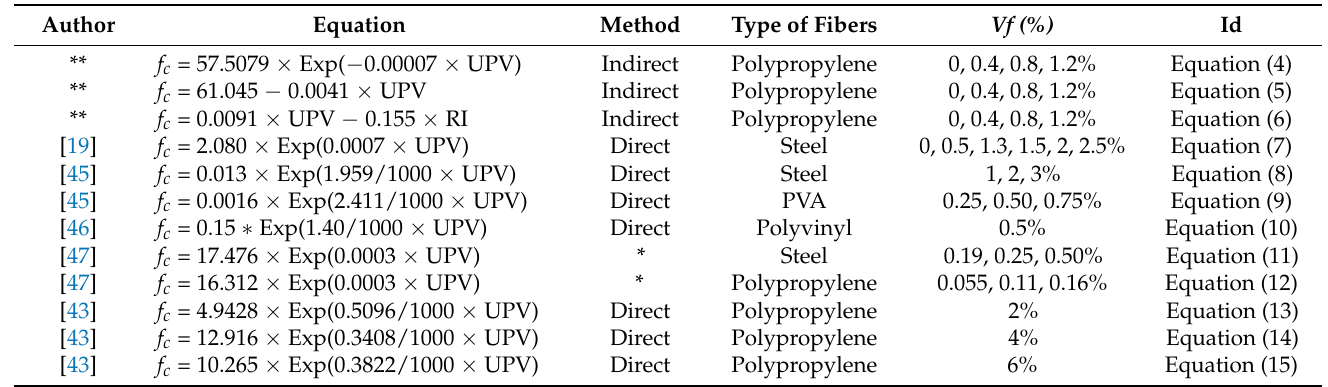
Table 6. Compressive strength prediction equations based on UPV.